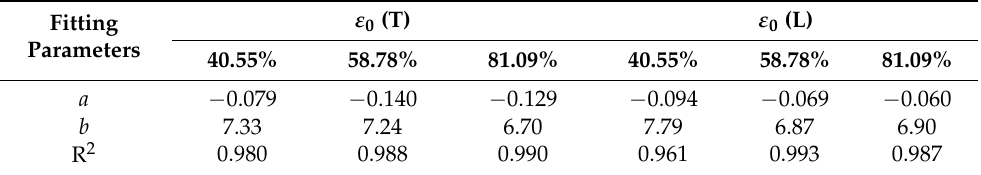
Table 3. Fitting parameters by fitting a line between K and tensile rate v .